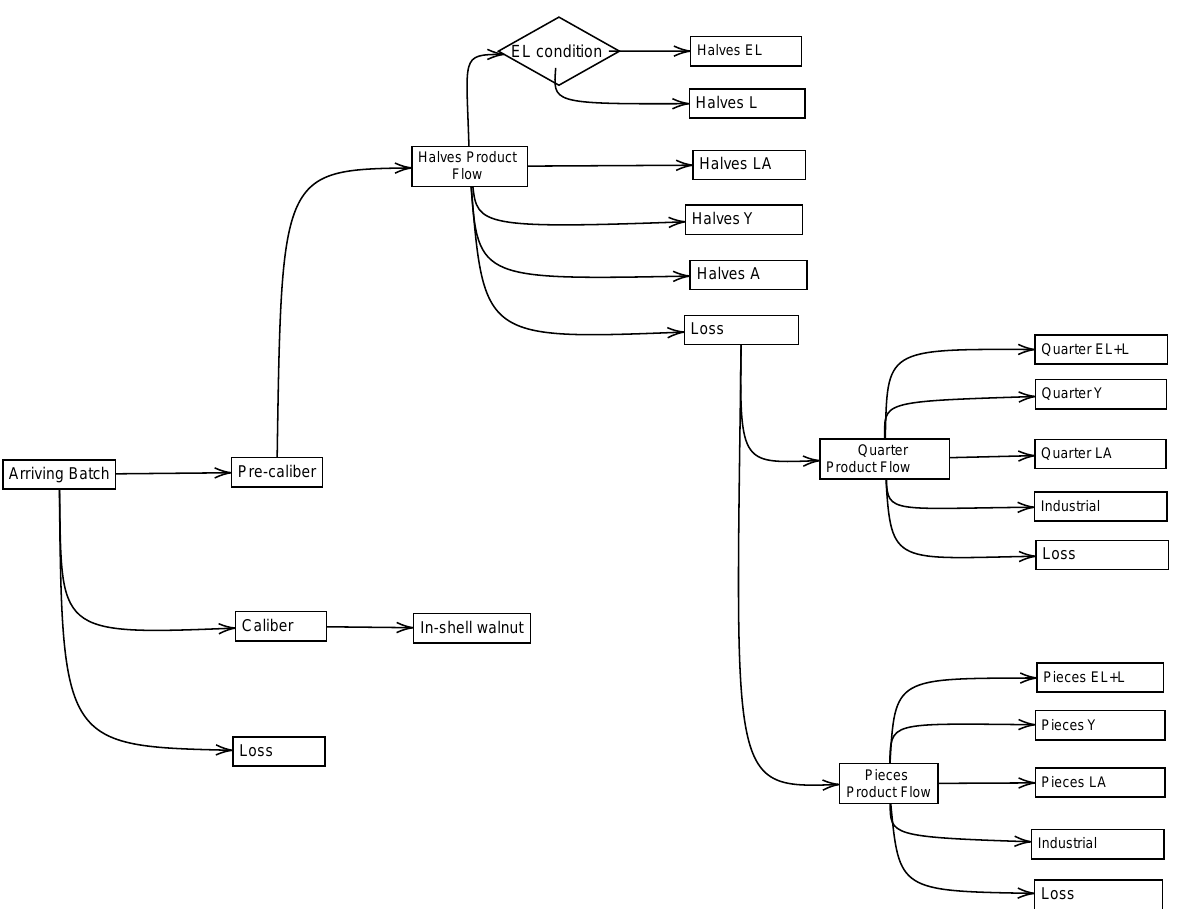
Figure 4. Arriving batch selling strategy